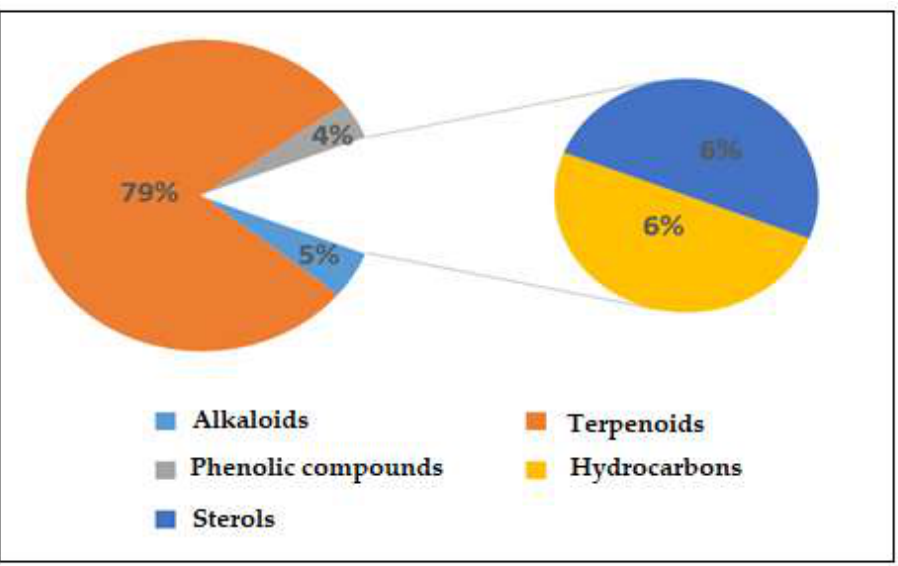
Figure 1. Percentages of chemical compounds extracted by acetic acid from Saussurea costus.